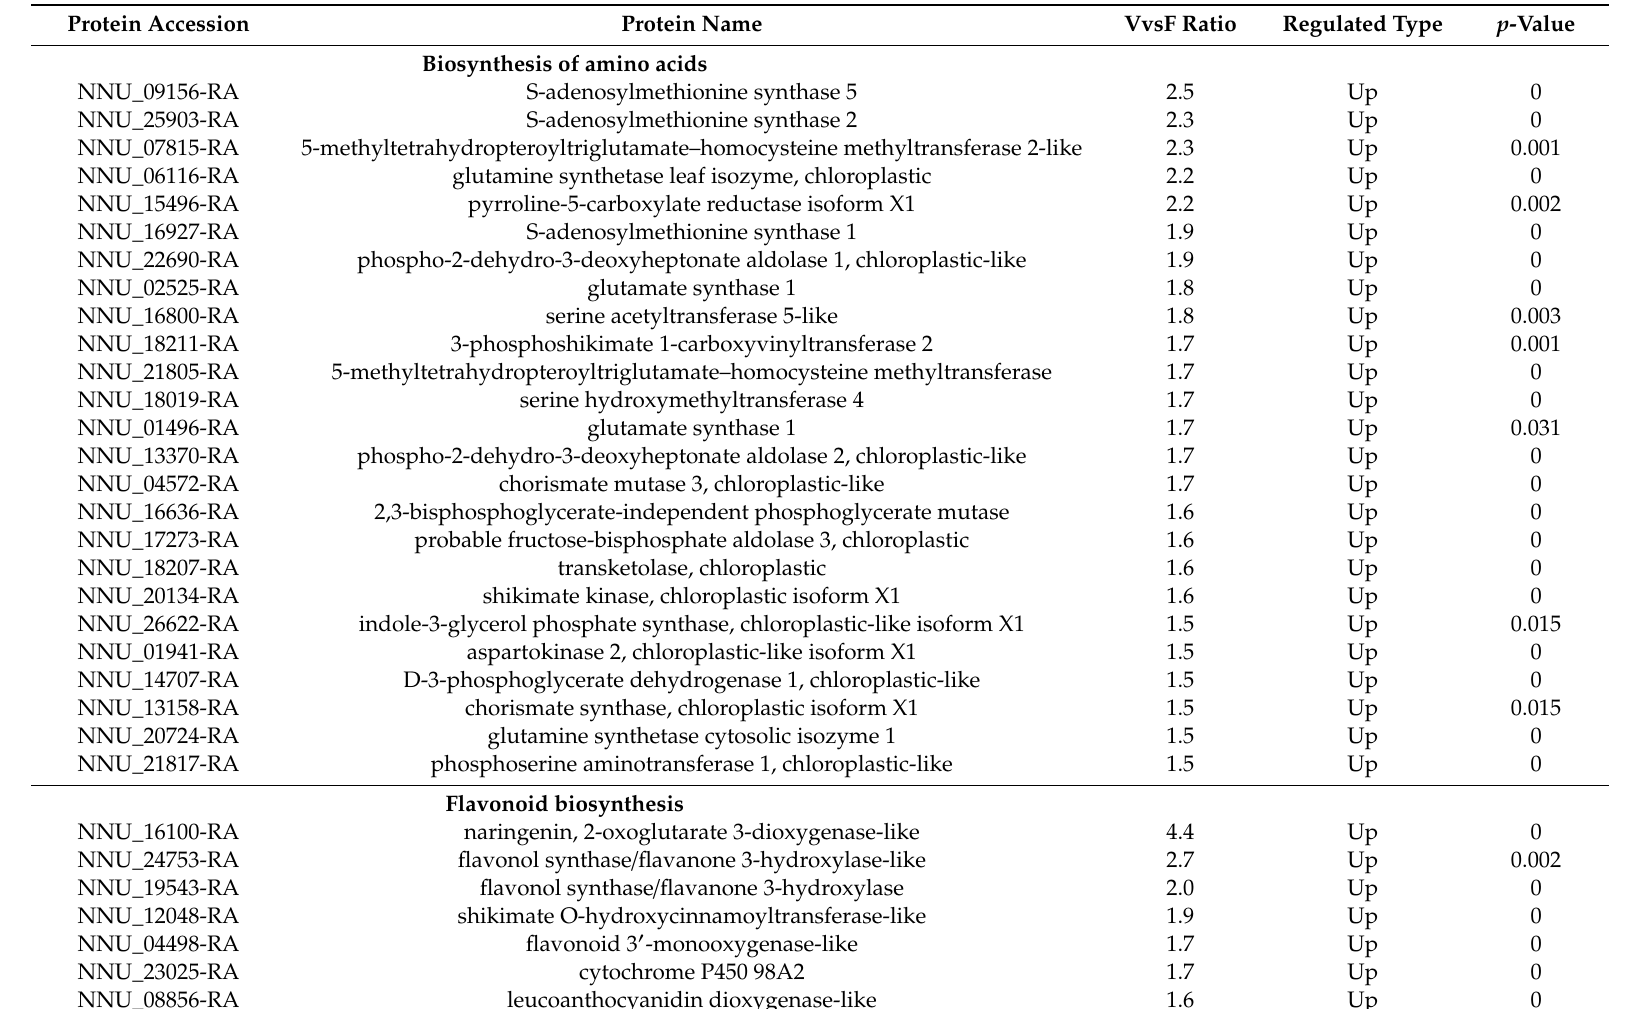
Table 2. Proteins involved in six biologic processes were significantly